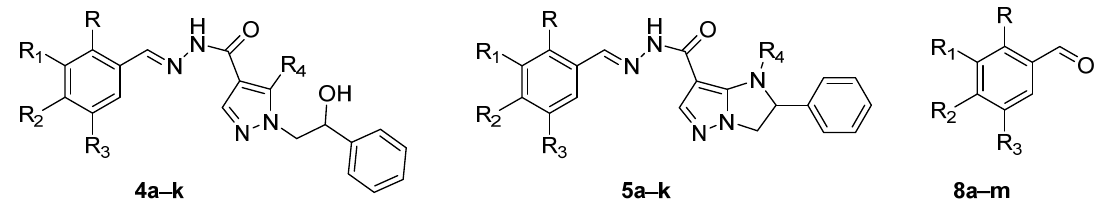
Figure 3. Structures of new hybrid compounds 4a–k, 5a–k and building block 8a – m used in their preparation. Table 1. Decorations on the hybrid structures 4a – k , 5a – k and the benzaldehydes 8a – m used for their preparation.